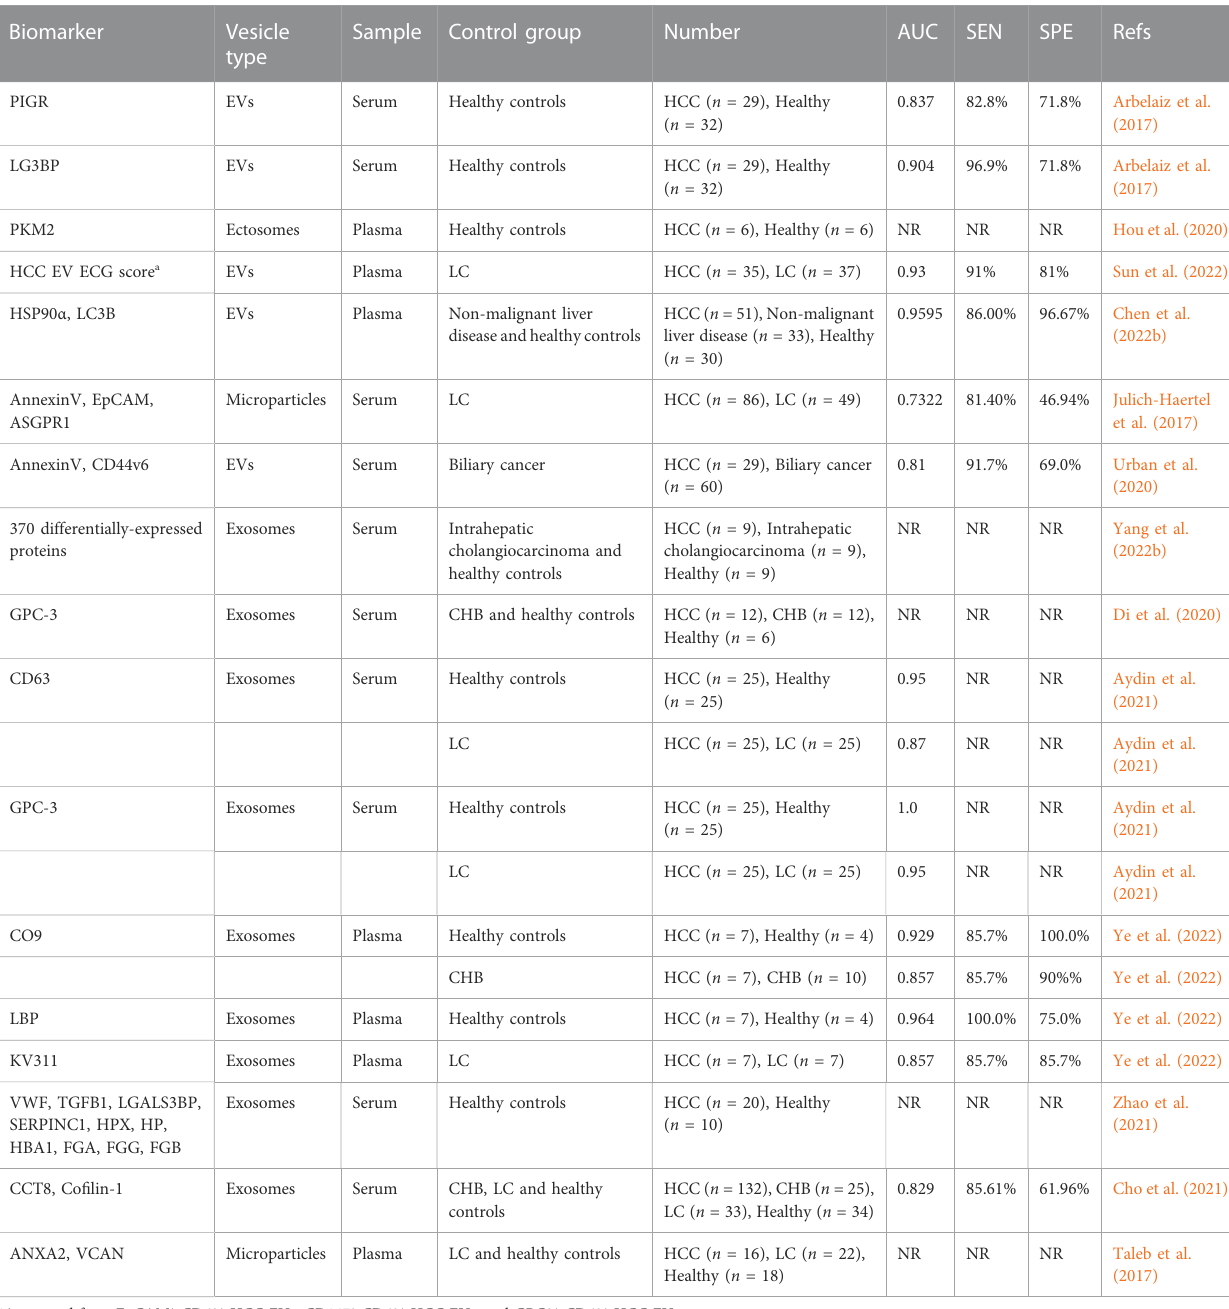
TABLE 2 Potential biomarkers identi fi ed in proteomics studies.